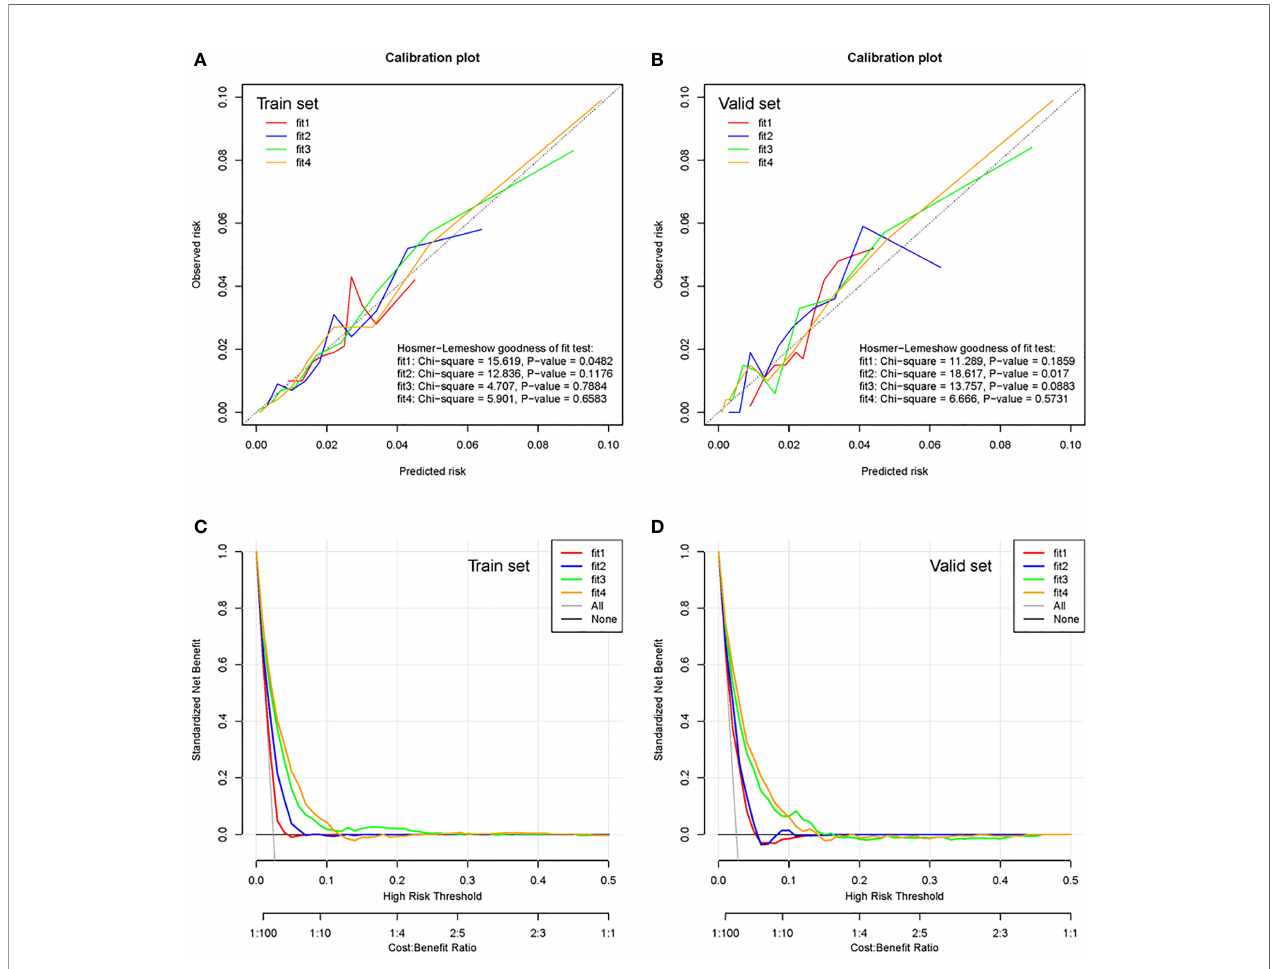
FIGURE 3 | Calibration plots and clinical decision curves of the training cohort and validation cohort. Calibration plots of the multiphase prediction models in the training cohort (A) and validation cohort (B) . Clinical decision curves of the multiphase models in the training cohort (C) and validation cohort (D) . Fit 1 represents the fi rst-phase prediction model, fi t 2 represents the second-phase prediction model, fi t 3 represents the third-phase prediction model, and fi t 4 represents the fourth- phase prediction